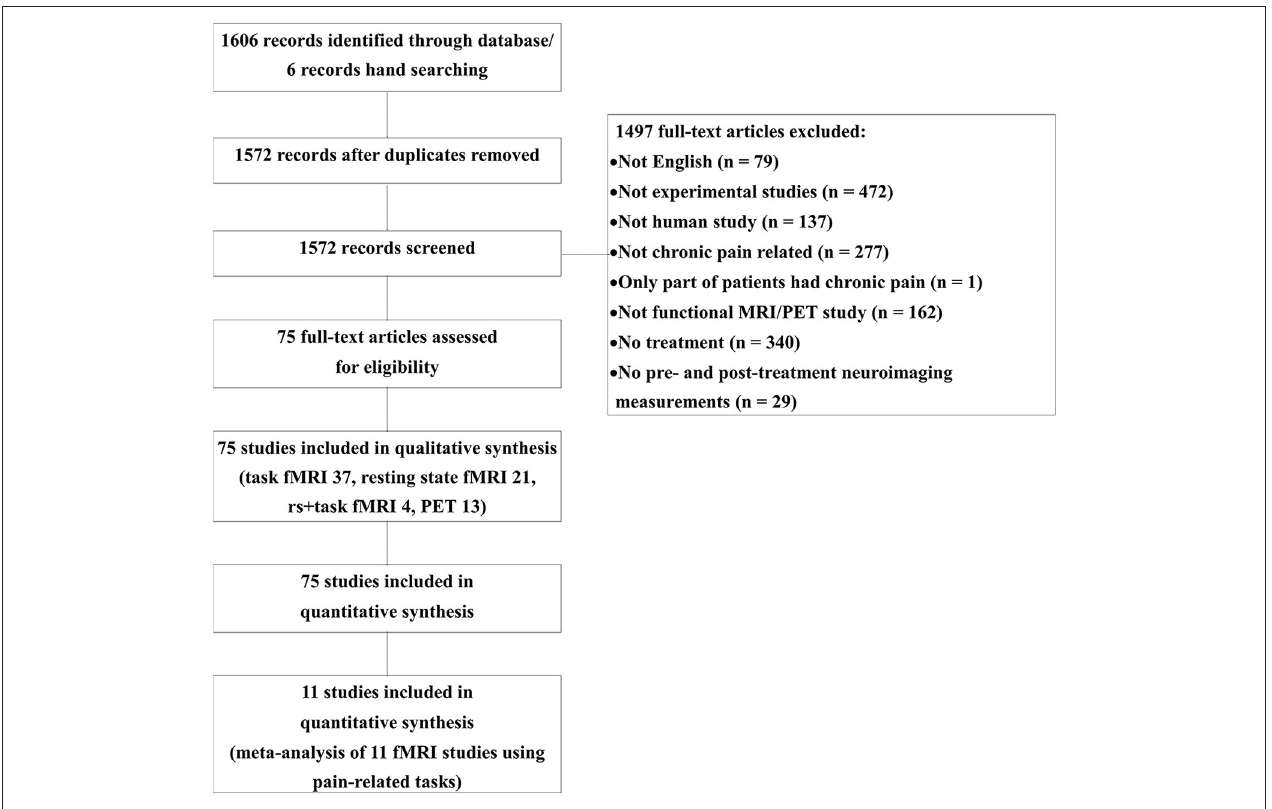
FIGURE 1 | Flow diagram of literature